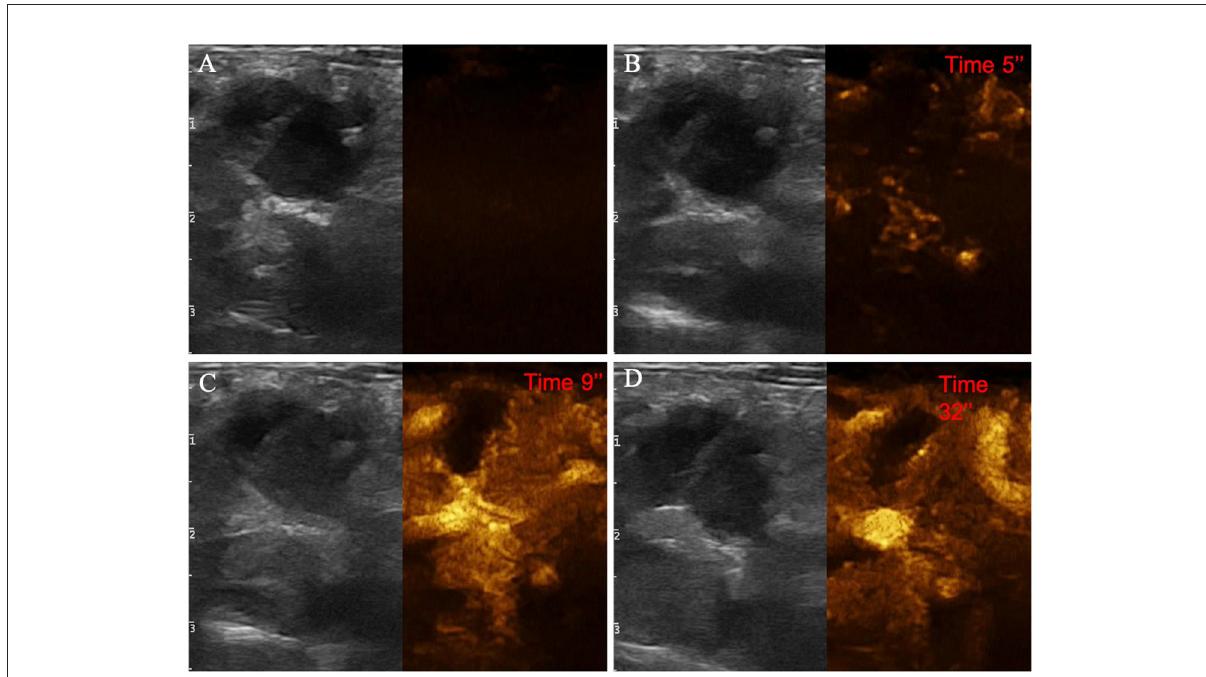
FIGURE8 Example of an adenocarcinoma showing: pseudocystic appearance, mixed echogenicity, presence of acoustic enhancement, and absence of peripancreatic reactivity at US; hypoenhancement, diffused and inhomogeneous distribution of contrast medium, presence of intralesional microcirculation, and presence of hypoperfused areas during wash-in phase at CEUS; hypoenhancing, inhomogeneous and diffused wash-out. (A) Image obtained from US examination; (B) image obtained at TTE; (C) image obtained at TTP; (D) image obtained during